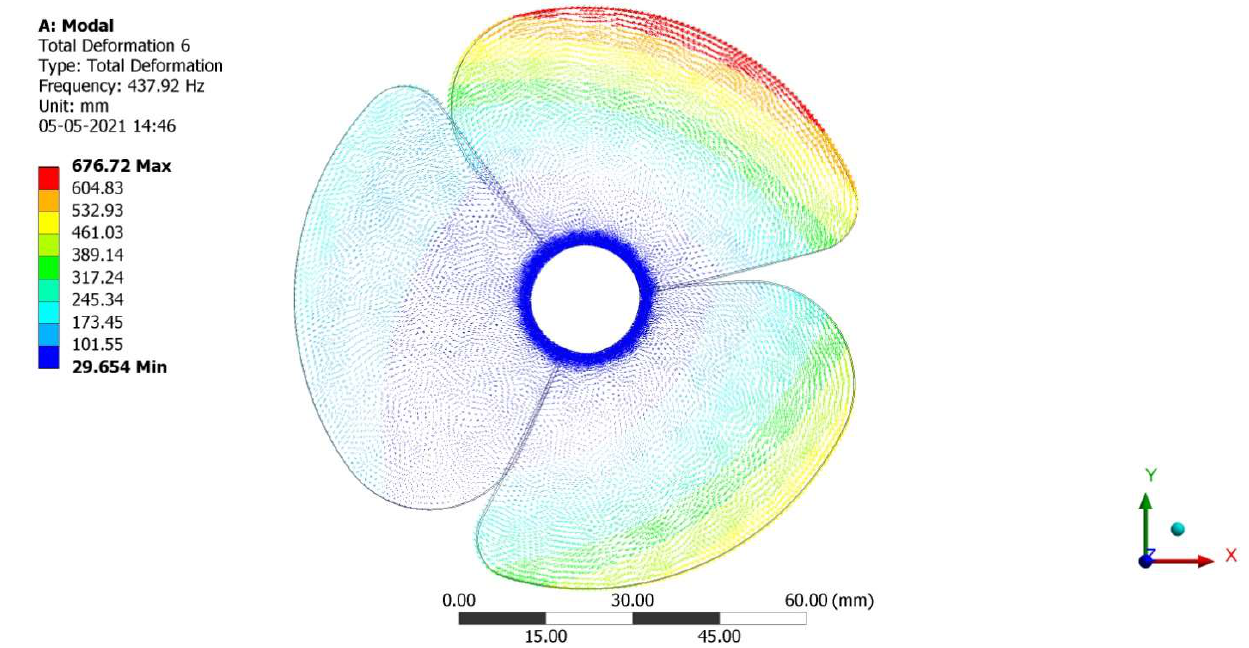
Figure 44. Sixth mode shape outcome of Magnesium Alloy.